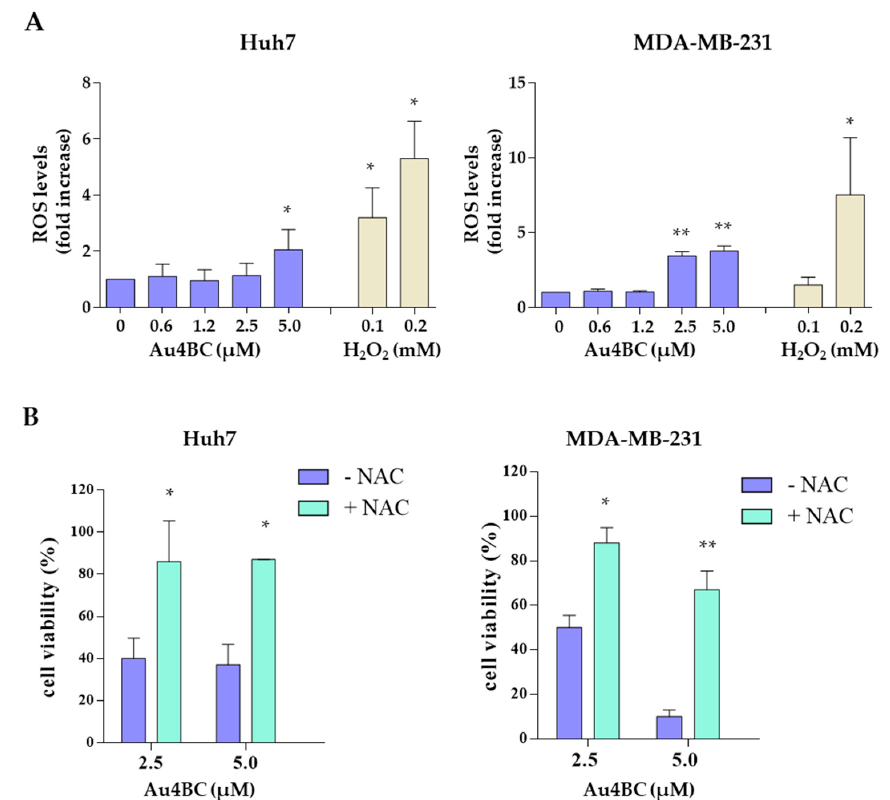
Figure 6. ROS generation in Huh7 and MDA-MB-231 cells treated with Au4BC. ( A ) Cells were untreated or treated with Au4BC at the indicated concentrations for 48 h, and intracellular ROS levels were evaluated using H 2 DCFDA as a probe. Hydrogen peroxide (H 2 O 2 ) was used as a positive control. Data are expressed as the percentage of control cells and are the means ± SD of two separate experiments, each performed in triplicate. * p < 0.05, ** p < 0.01. ( B ) Huh7 and MDA-MB-231 cells were pre-treated for 2 h with 5 mM NAC and then treated with Au4BC for 24 h in the presence or absence of NAC. Cell viability was assessed by an MTS assay. Data are expressed as in Figure 4. * p < 0.05; ** p < 0.01.